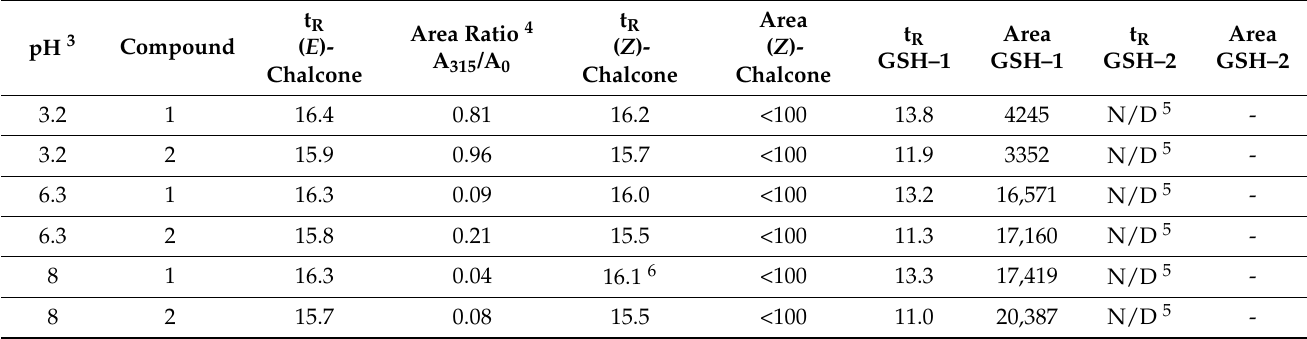
Table 1. Retention times (t R ) 1 and integrated peak areas (A) of the investigated chalcones ( 1 and 2 ) and their GSH adducts 2 .